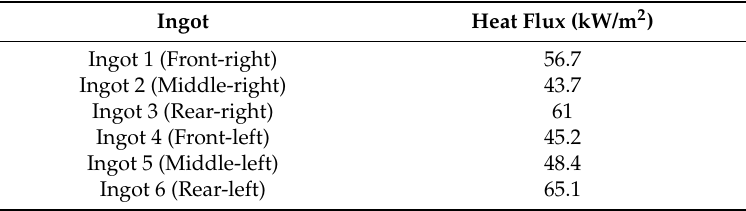
Table 5. Wall boundary conditions for the ingots